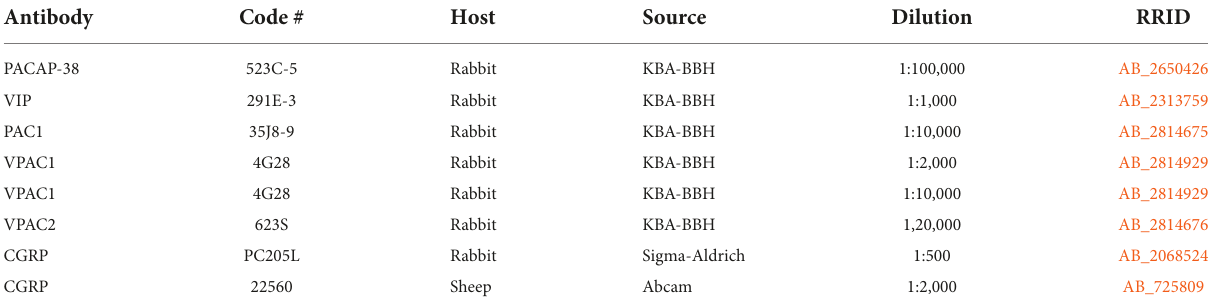
TABLE 1 Primary antibodies.